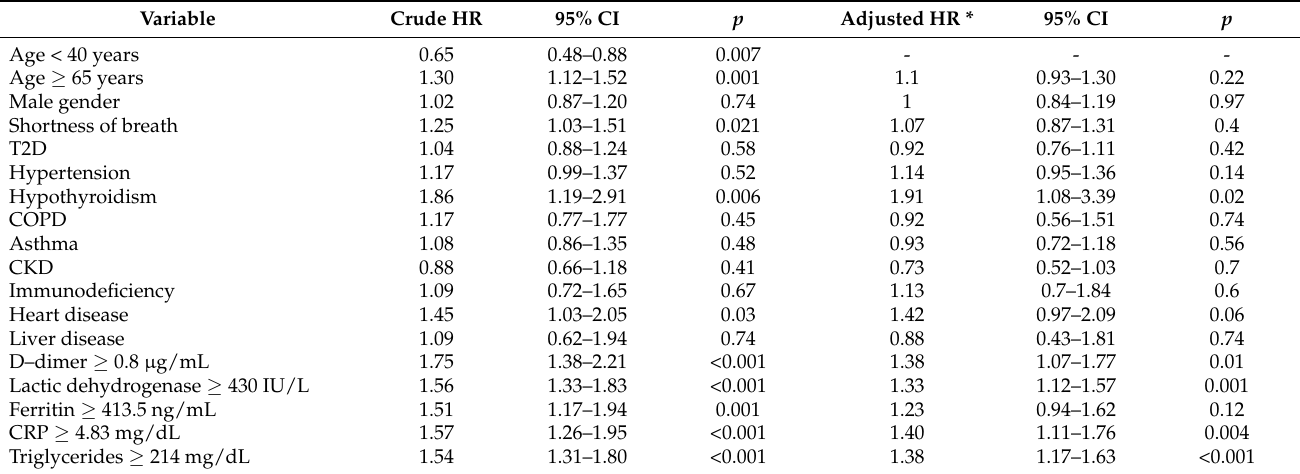
Table 2. Cox proportional hazard model for 30-day mortality in hospitalized patients with COVID-19 (n =